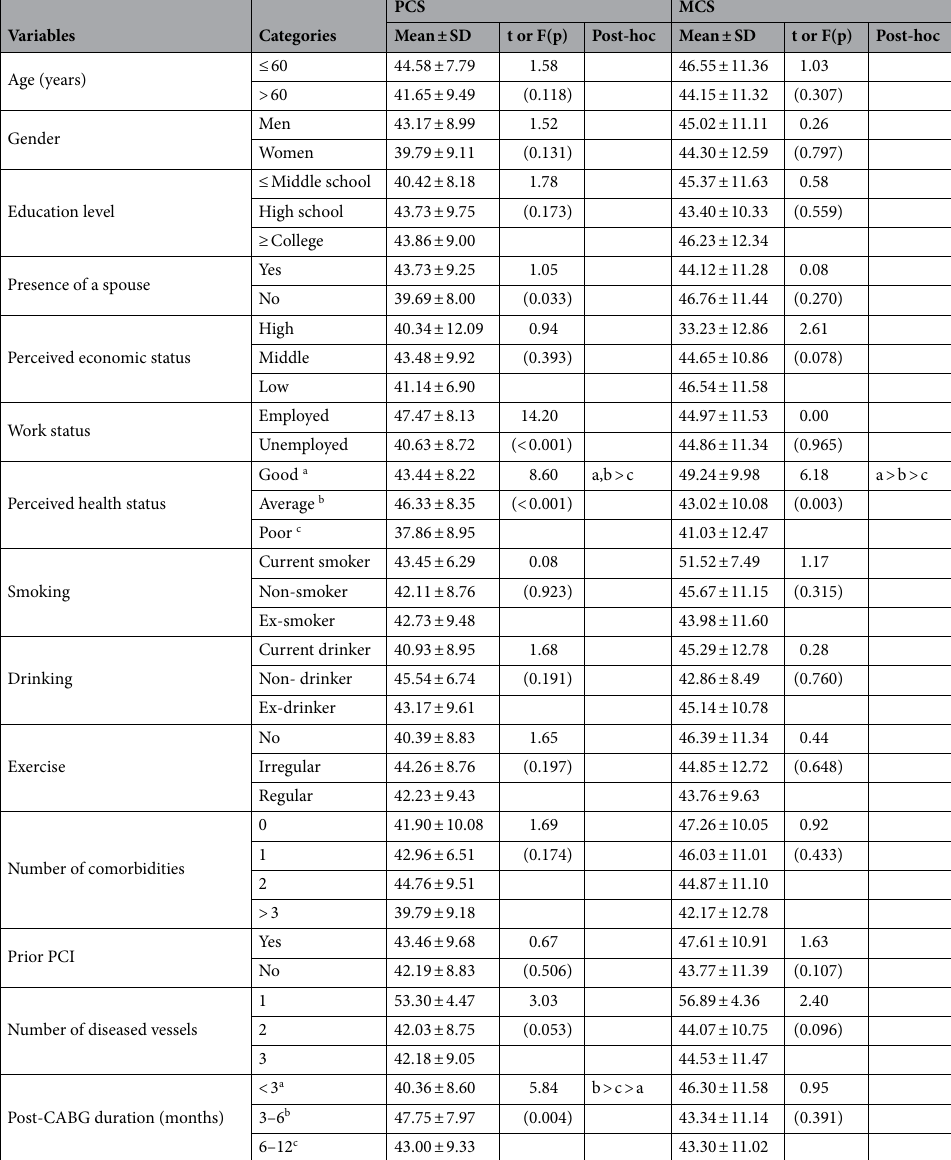
Table 3. Health-related Quality of Life according to characteristics of the patients (N = 110). Note: Alphabet (a to c) used as a superscript for categories indicates the alphabet used to describe statistically significance difference. The mean difference is significant at the 0.05 level. PCS physical component summary, MCS mental component summary, PCI percutaneous coronary intervention, CABG coronary artery bypass graft.